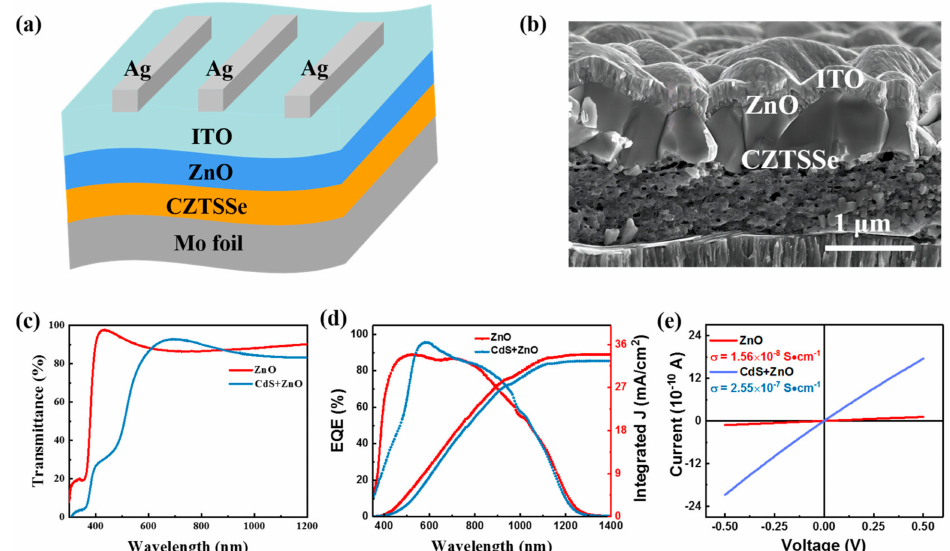
Figure 1. ( a ) The schematic diagram of device structure and ( b ) the cross-section SEM image for the flexible CZTSSe/ZnO solar cell. ( c ) Transmittances of the ZnO and CdS/ZnO buffer layers. ( d ) EQE curves of devices based on ZnO and CdS/ZnO buffer layers. ( e ) SCLC of ZnO and CdS/ZnO buffer